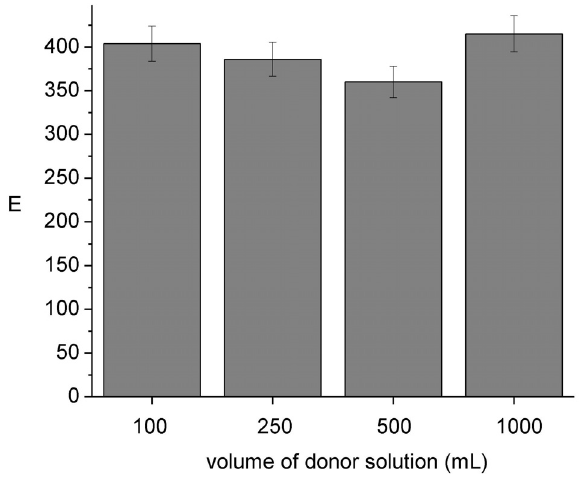
Figure 6. Influence of the sampling volume on the enrichment factor. Donor phase: 1.2 × 10 − 5 mol L − 1 Ni(II), 0.01 mol L − 1 MES, pH 6.6; acceptor phase: 0.01 mol L − 1 HCOOH, pH = 2; membrane phase: 0.012 mol L − 1 Kelex 100; 300 min of sampling